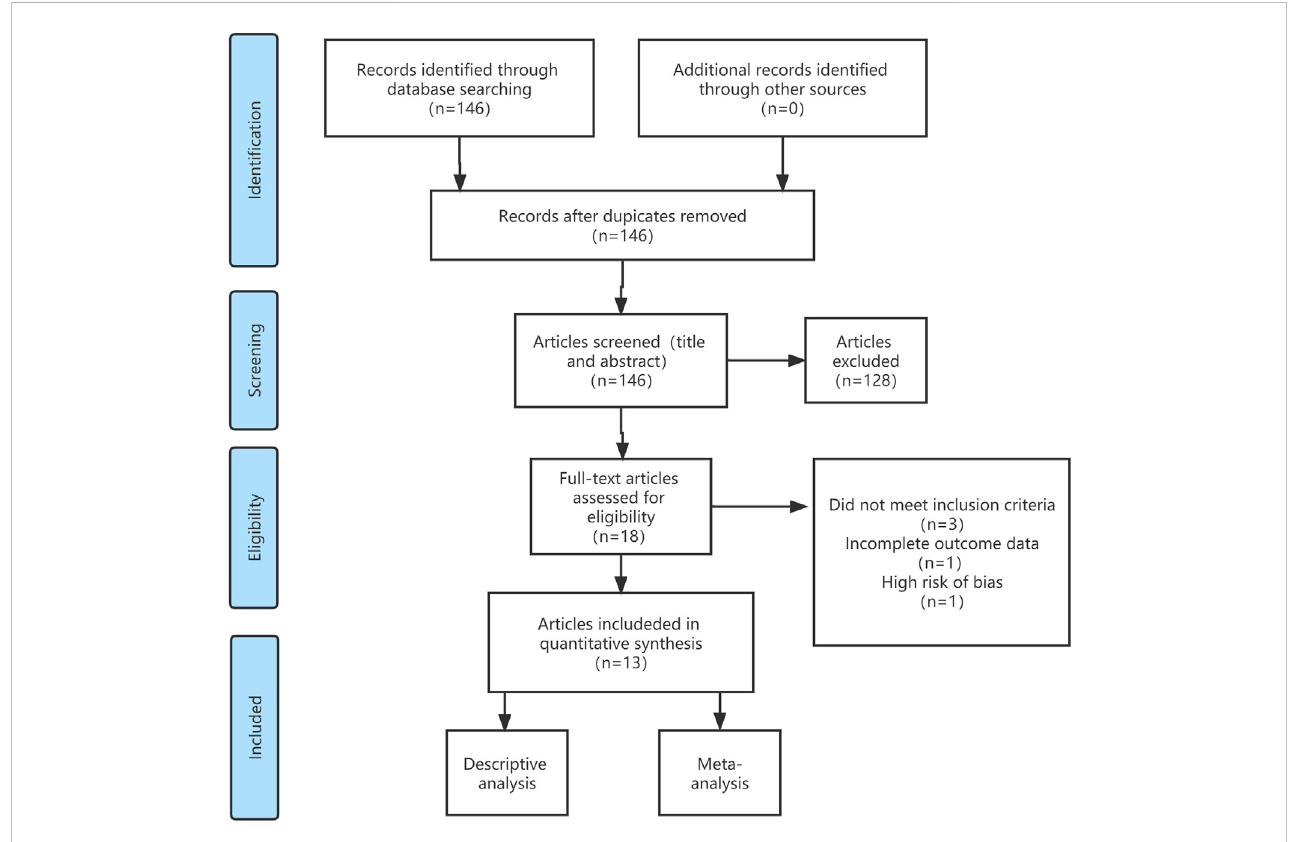
FIGURE 1 Flow chart of the literature search and inclusion